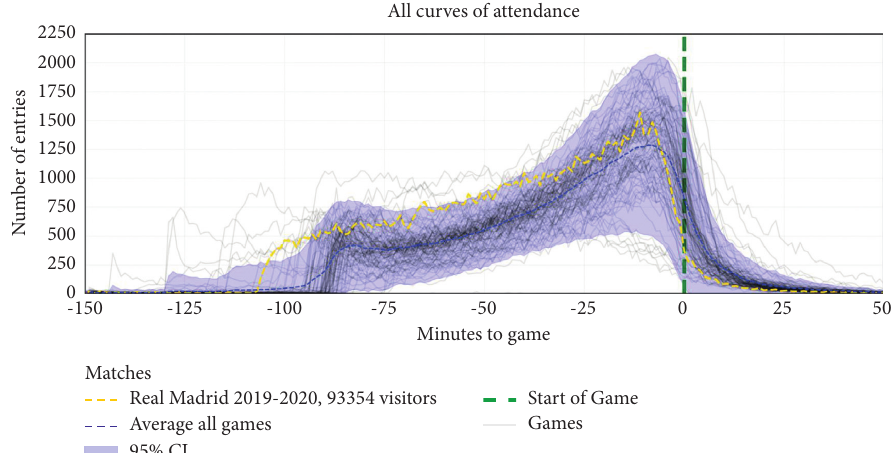
Figure 7: Attendance pattern chart showing the overall arrivals at the venue for four seasons (2016–2020), including more than 100 matches (each line represents one match). Different patterns can be discerned, showing that each match has a unique pattern of attendance. This chart also shows that there are some clusters of matches, as different kinds of matches have different numbers of arrivals at different times. The blue dashed line shows the average number of arrivals per match with respect to the minutes before and after the match for any given match. The corresponding confidence band (total width of 2 standard deviations) is depicted in